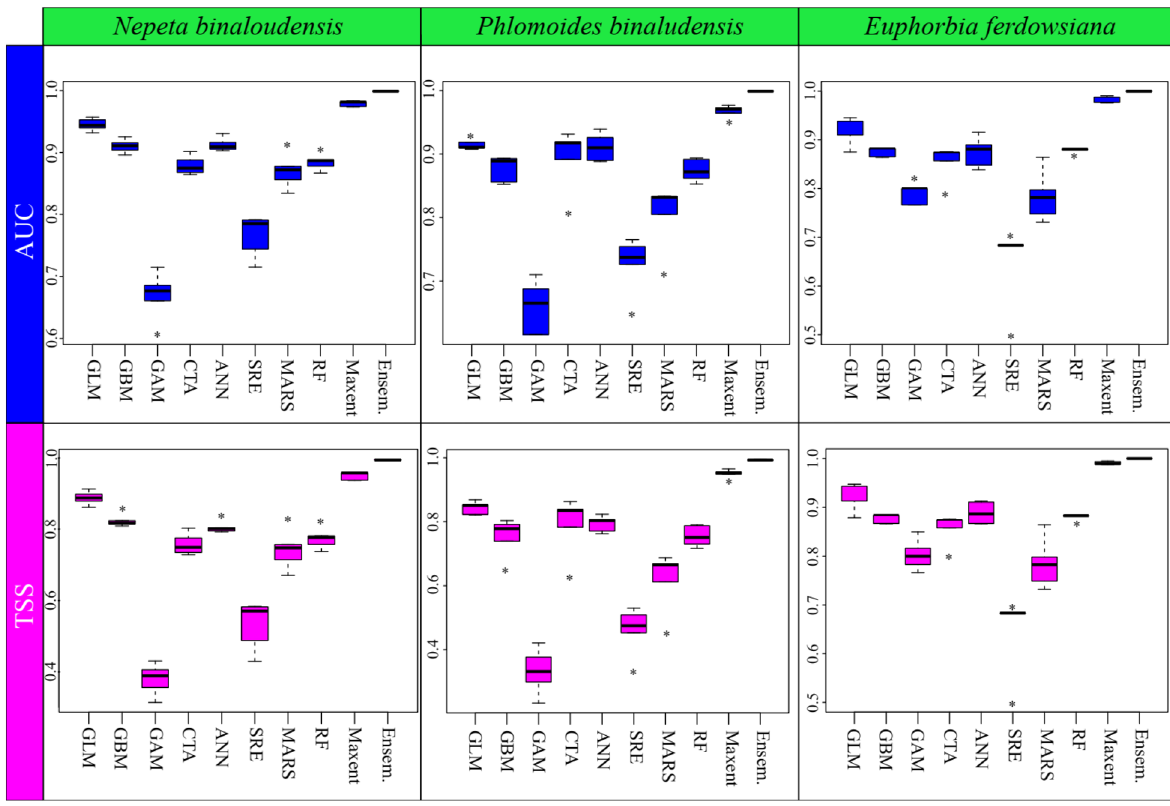
Figure 2. Boxplots showing the AUC and TSS scores for model evaluation from ten cross ‐ validation runs on test data for the nine SDM algorithms that were used for the prediction of three species distribution in the Khorassan-Kopet Dagh floristic province. For comparison, the evaluation scores for the ensemble model are shown. The ensemble model does not include those models with a TSS < 0.9. See the text for model